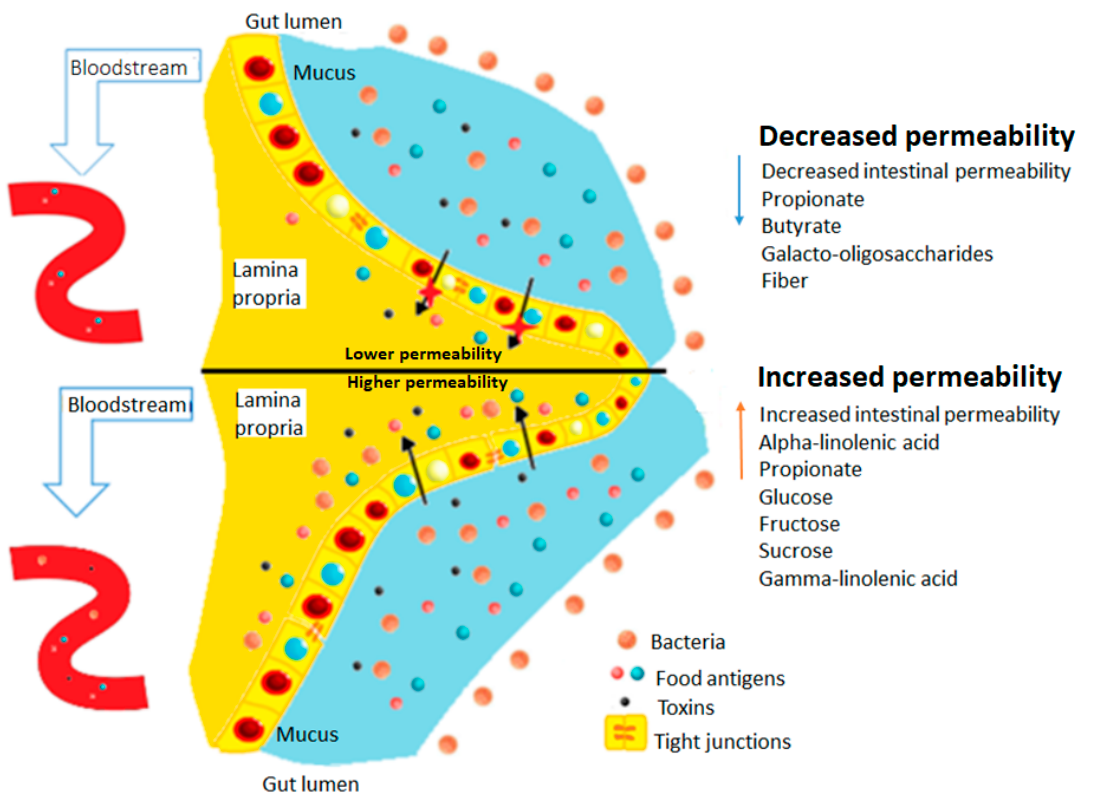
Figure 5. Effect of various components of the diet on the permeability of the intestinal epithelium. The components that decrease intestinal permeability appear on the upper part of the figure and those that increase it appear on the lower part of the figure.